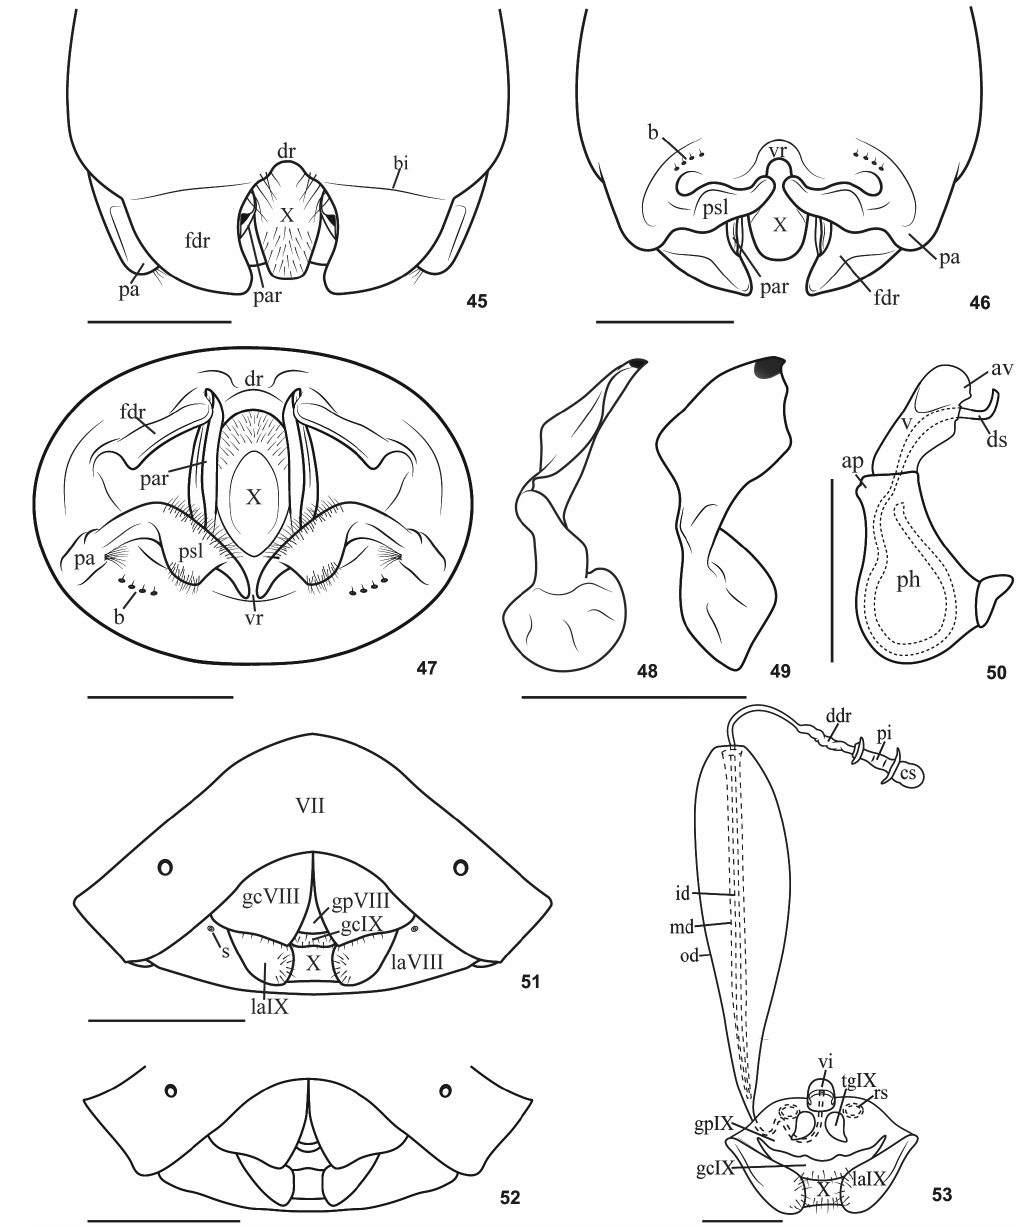
Figures 45–53. Lineostethus sinuosus sp. nov.: (45–47) male pygophore, dorsal, ventral and posterior views respectively; (48–49) left paramere, dorsal and lateral views; (50) phallus, lateral view; (51–52) female genital plates; (53) female receptaculum seminis. Abbreviations: ap, ventral apical projection of phallotheca; av, apical margin of vesica; b, bristles; bi, basal impression of foliaceous expansions; cs, capsula seminalis; ddr, distal ductus receptaculi; dr, dorsal rim; ds, ductus seminis distalis; fdr, foliaceous expansions of dorsal rim; gcVIII, gonocoxites VIII; gcIX, gonocoxites IX; gpVIII, gonapophyses VIII; gpIX, gonapophyses IX; id, internal duct of vesicular area; la8, laterotergites VIII; la9, laterotergites IX; md, median duct of vesicular area; od, outer duct of vesicular area; pa, posterolateral angle; par, paramere; ph, phallotheca; pi, pars intermedialis; psl, projection of superior layer of ventral rim; rs, ring sclerites; s, spiracle; tgIX, thickening of gonapophyses IX; v, vesica; vi, thickening of vaginal intima; vr, ventral rim; VII, urosternite VII; X, segment X. Scale bars: 45–49, 51–52 = 1 mm; 50, 53 = 0.5 mm. ZOOLOGIA 35: e21232 | DOI: 10.3897/zoologia.35.e21232 | November 1, 2018 15 /